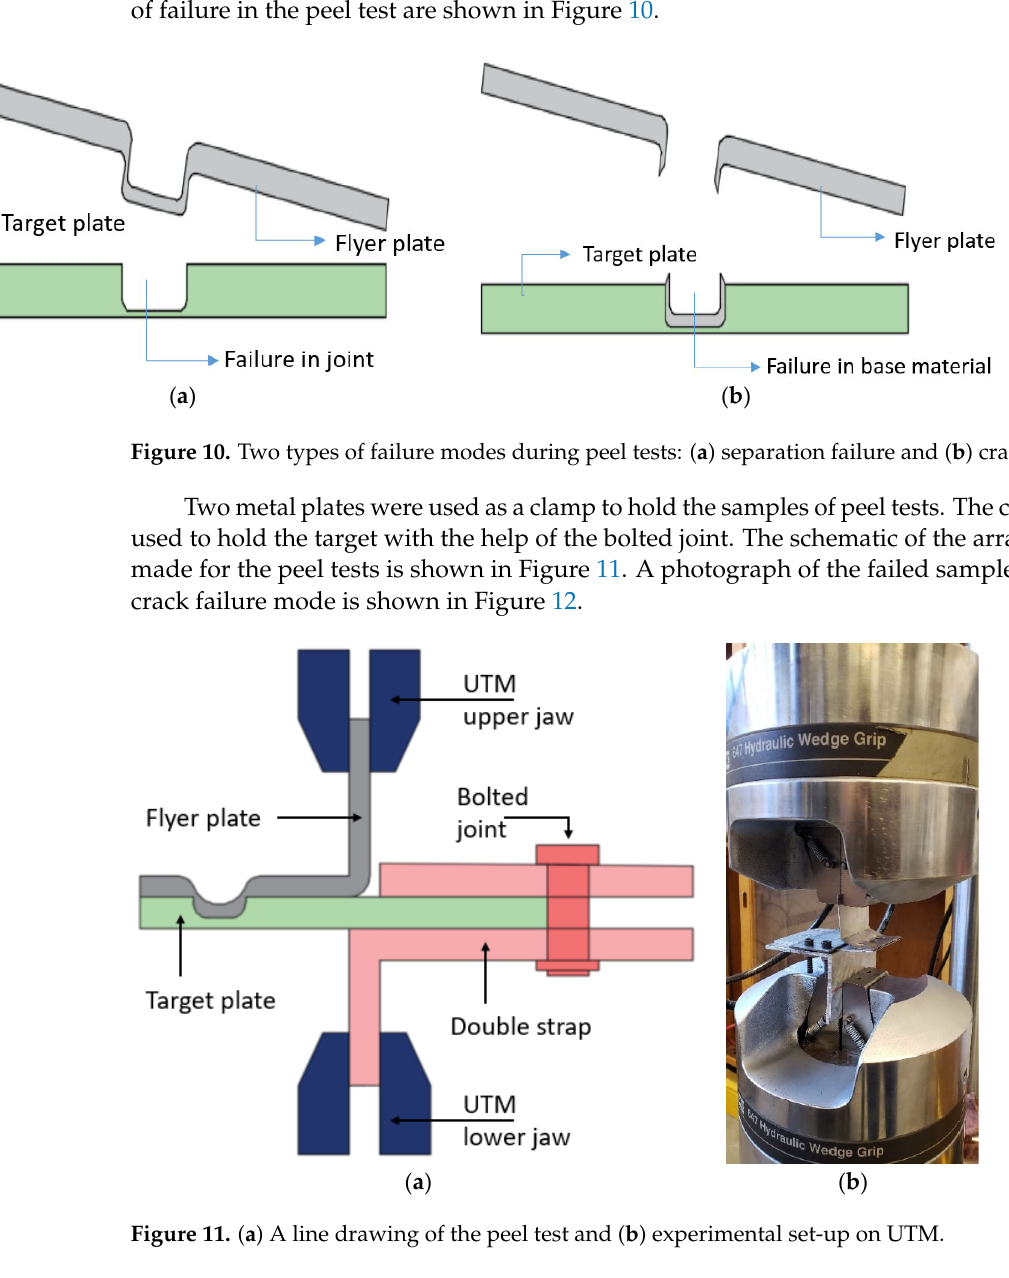
Figure 9. Multi ‐ spot EMJ samples by four different input energies: 7, 8, 9 and 10 kJ.